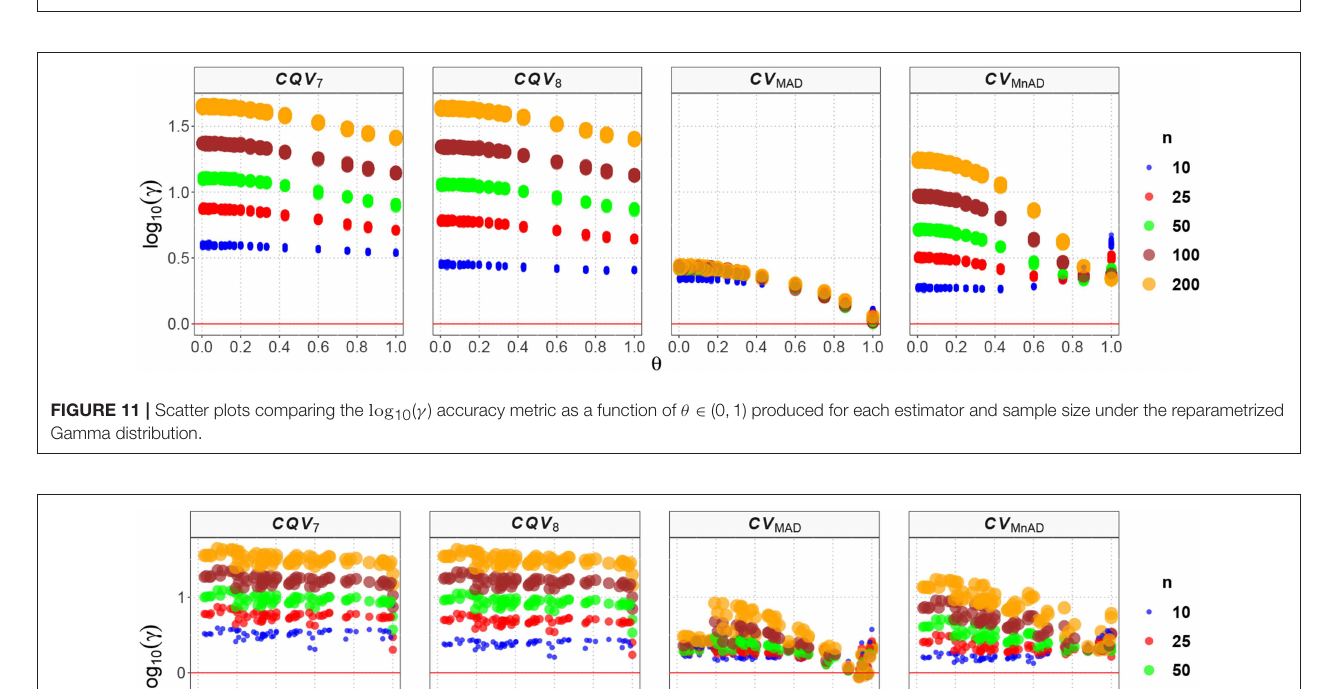
FIGURE 10 | Scatter plots comparing the log 10 ( γ ) accuracy metric as a function of θ Beta distribution.